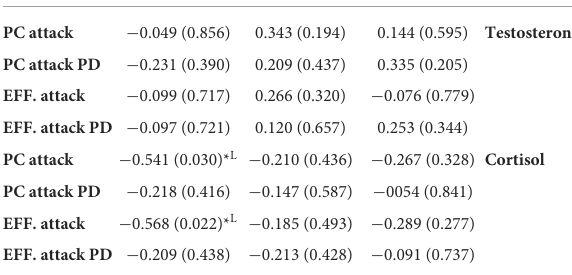
TABLE 3 Correlation between technical-tactical key components of volleyball performance with hormonal analyses.